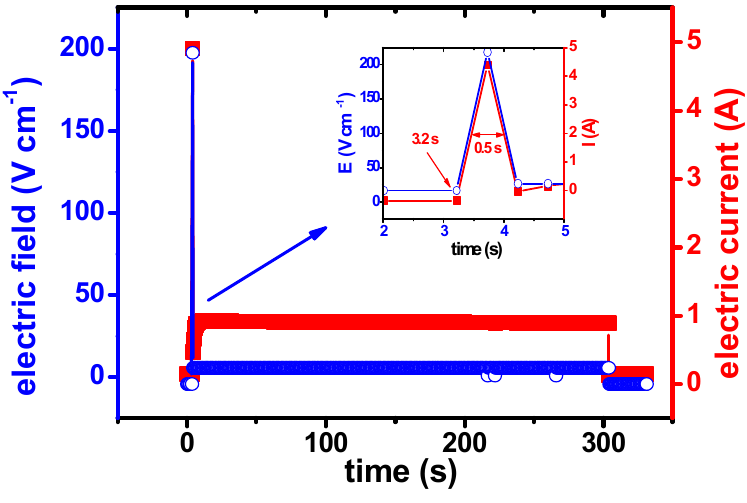
Figure 1. Time evolution of applied electric field and electric current through a BITIVOX pellet during 300 s at 800 °C. Inset: exploded view of the first 5 s under the electric field.